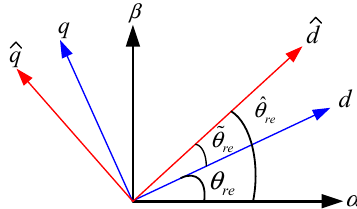
Figure 4. Estimated and real rotor positions.